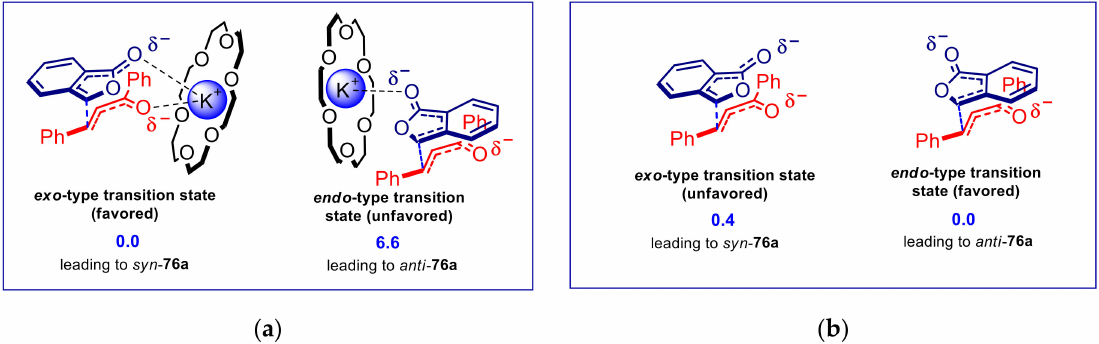
Figure 4. DFT calculations of the transitions states for the AMR of 1(3 H )isobenzofuranone and trans -chalcone. Relative energies of the transition states, expressed in kcal/mol, are shown in blue. ( a ) Chelated model of the transition state involving the dienolate/K + ⊂ 18-crown-6 tight ion pair in toluene; ( b ) Model of the transition state involving the “naked” dienolate anion in